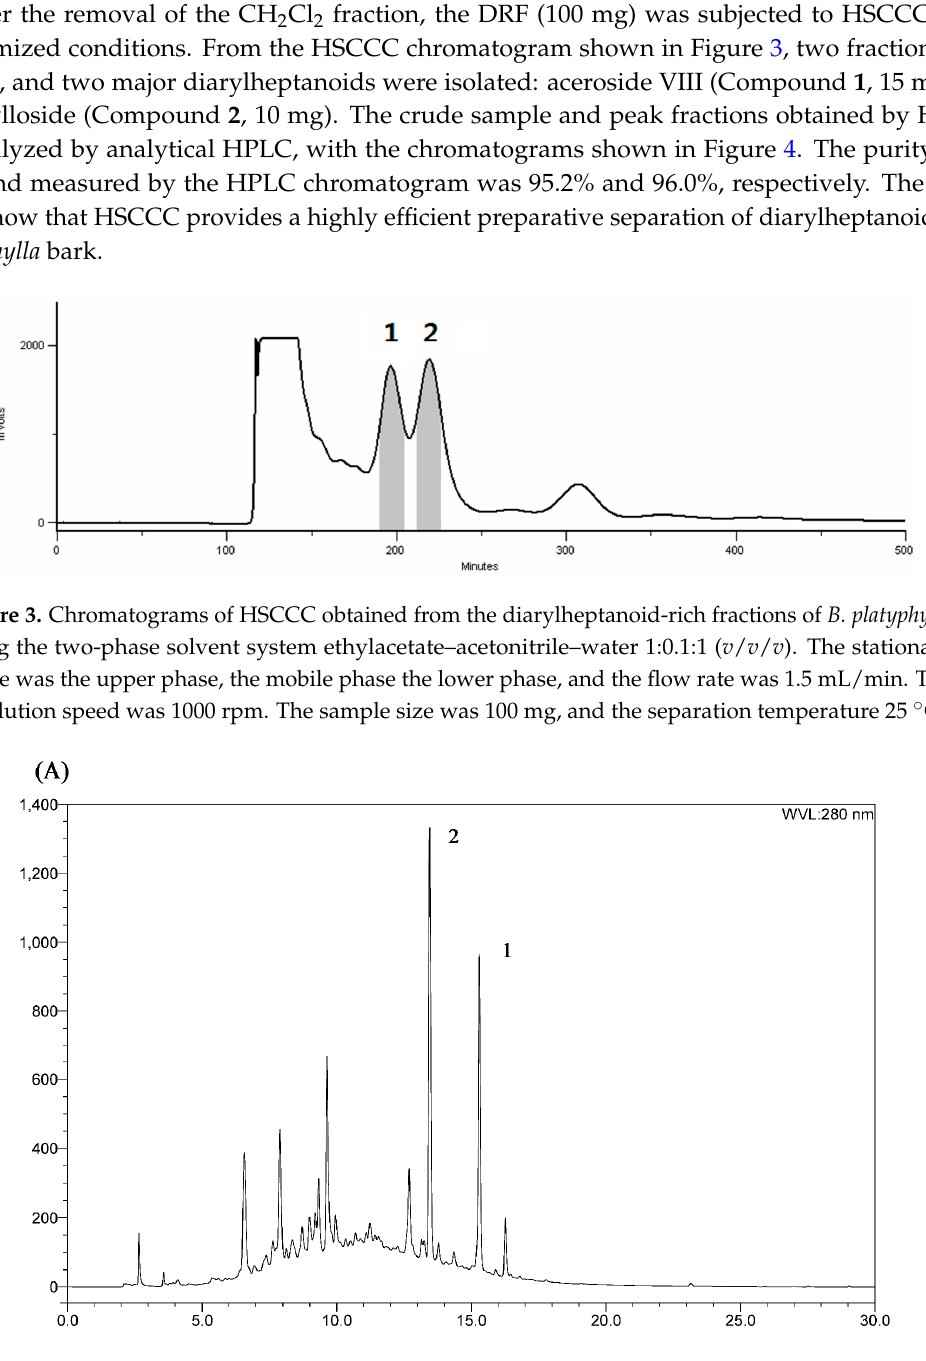
Table 1. K values and separation factors of compounds aceroside VIII ( 1 ) and platyphylloside ( 2 ). Solvent System